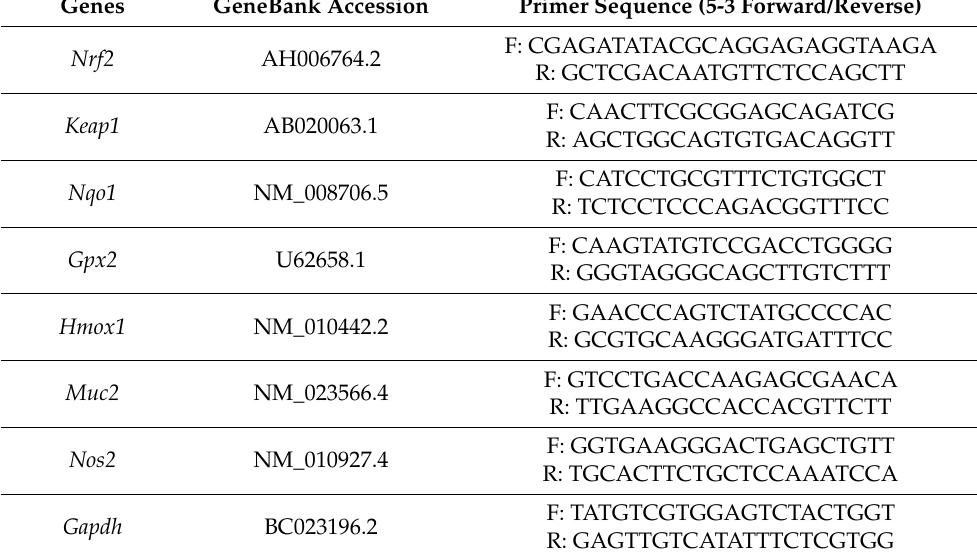
Table 1. Primers used for